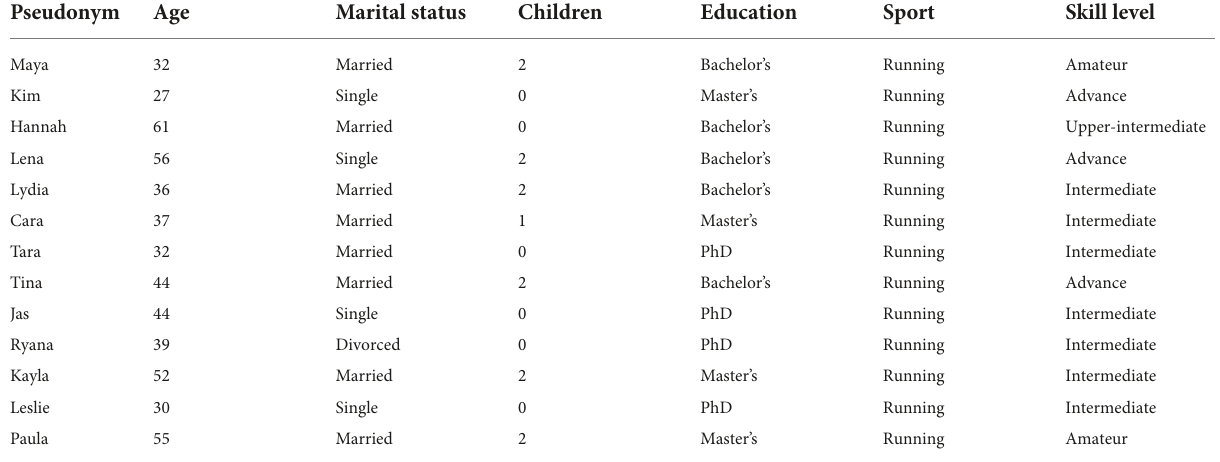
TABLE 2 Profile of the